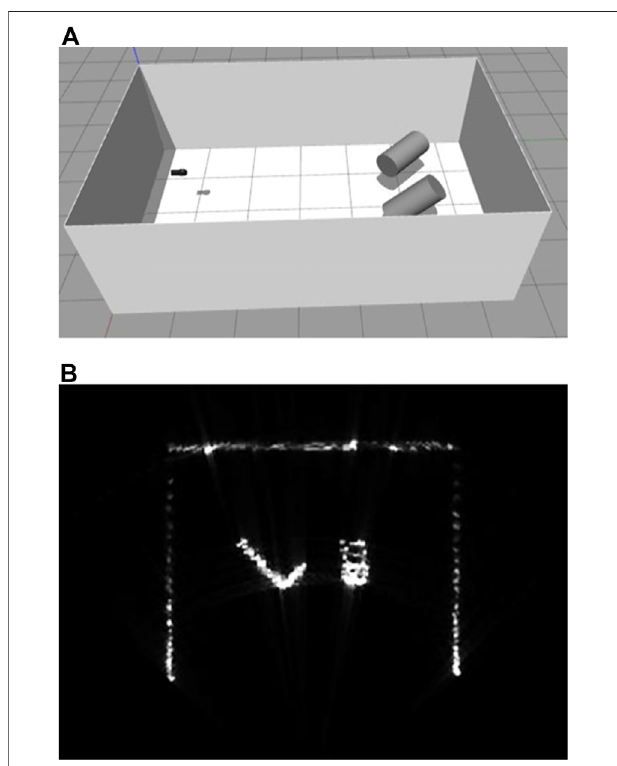
FIGURE 11 | Simulated multibeam echosounder image of two tilted cylinder targets [ (A) simulation environment, (B) live-view sonar image].